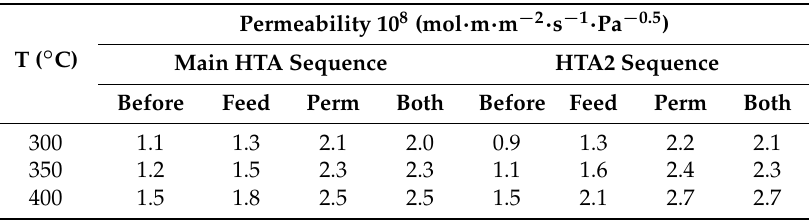
Table 1. Permeability measured at 300 ◦ C after before, between and after each of the three steps in the main HTA membrane side sequences for the 2.2 µ m thick